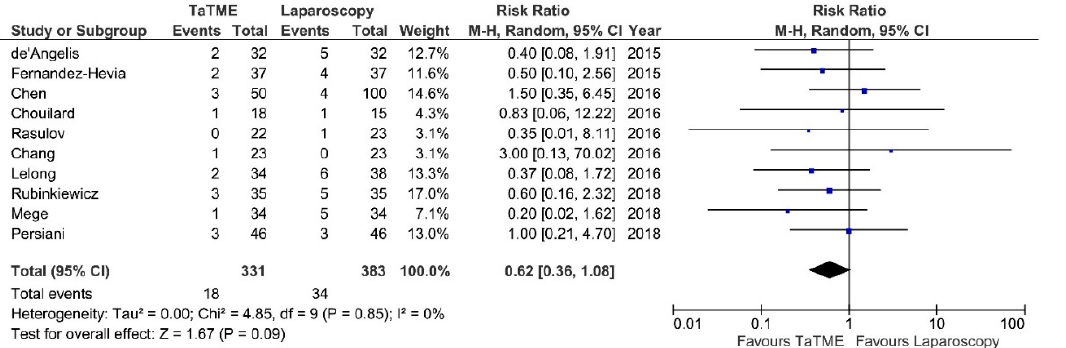
Figure 6. Anastomotic leakage. CI—Confidence Interval; df—degrees of freedom, M-H—Mantel-Haenszel test. WMD and RR are presented on the graphs as squares, and overall WMD and RR is presented as diamond.